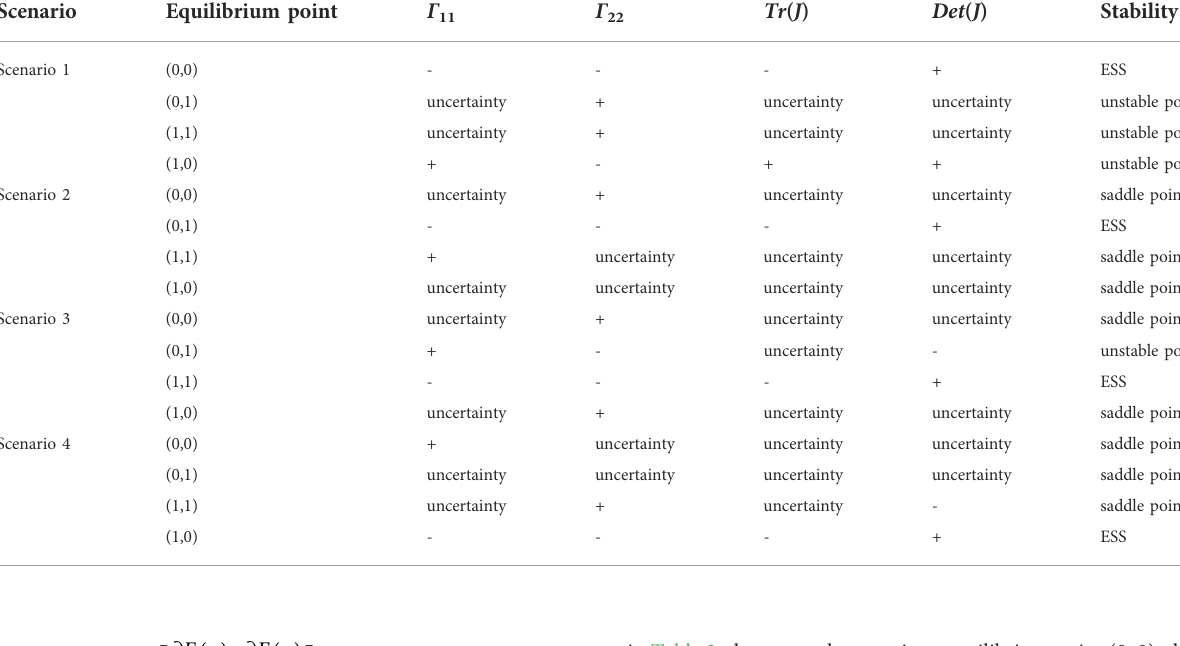
TABLE 3 Analysis of strategy stabilization equilibrium points.